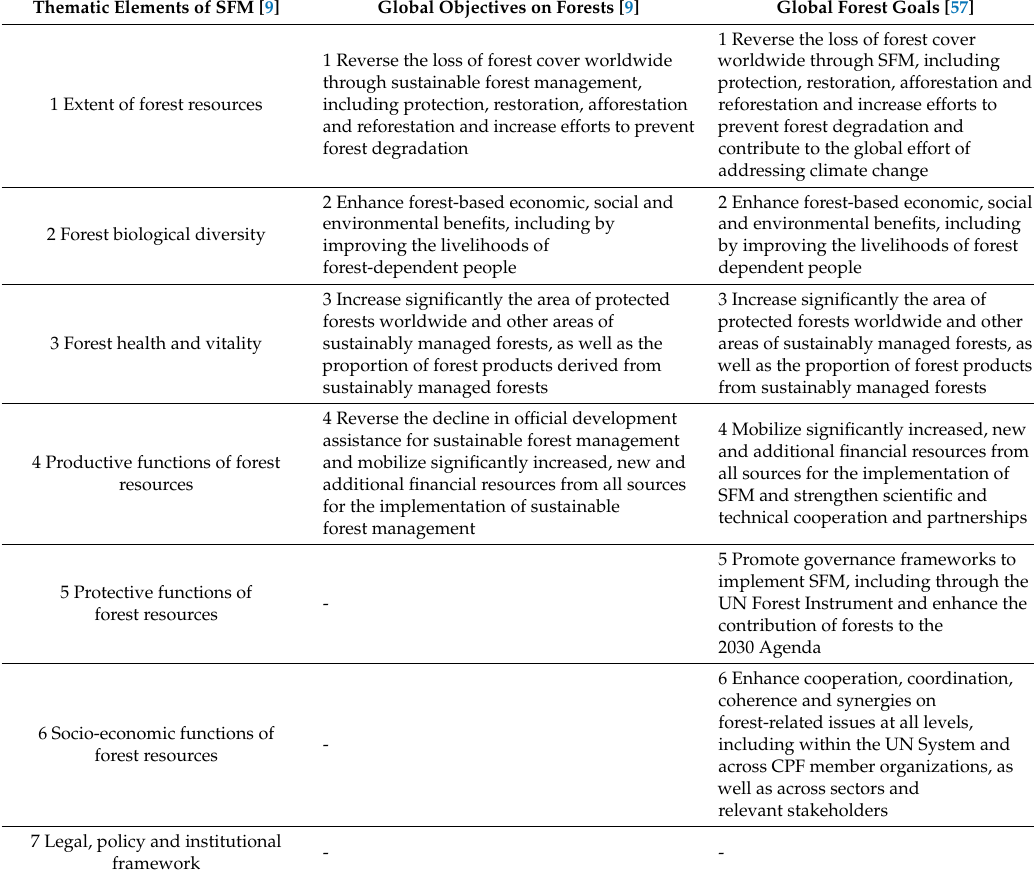
Table 2. Global requirements that were inspired by regional and international criteria for